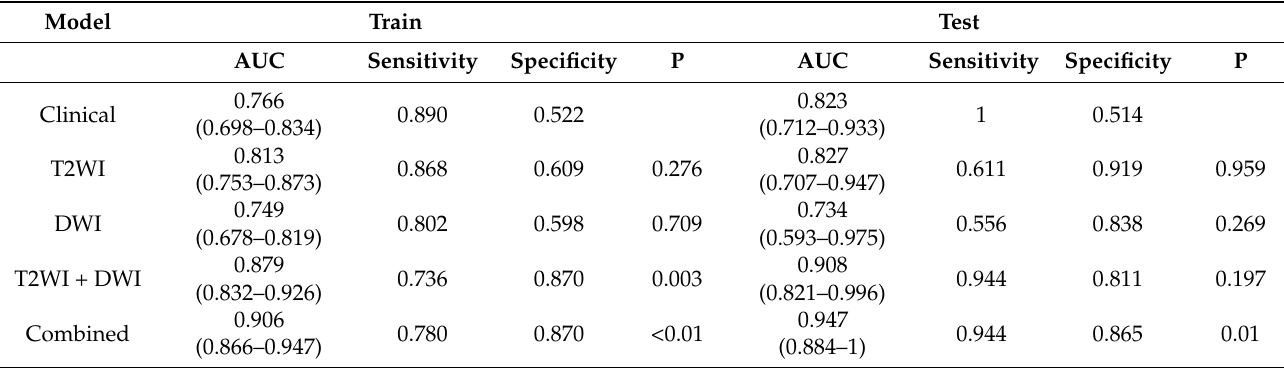
Table 4. The diagnostic performance of